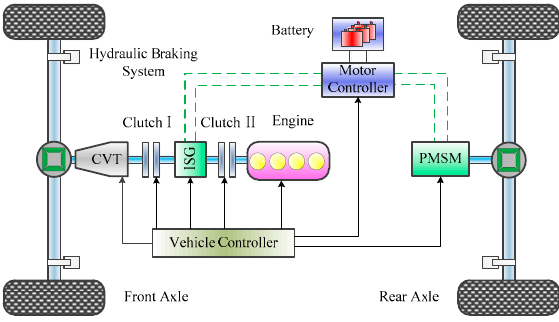
Figure 1. Structure of a plug-in hybrid vehicle.